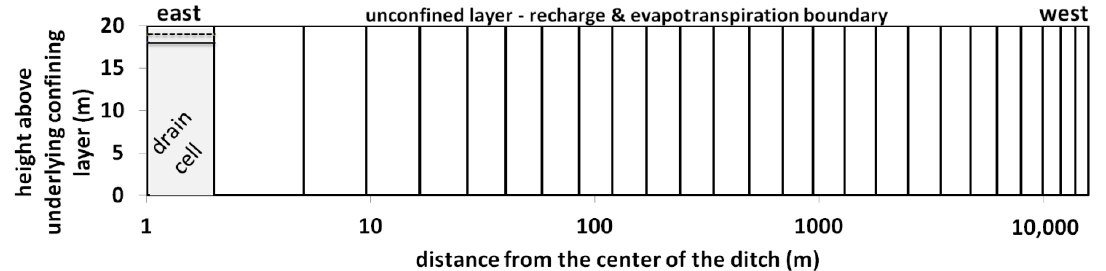
Figure 8. Spatial discretization of the profile model. The dashed and solid lines within the drain cell show the initial and incised elevation of the steady-state and transient model, respectively.